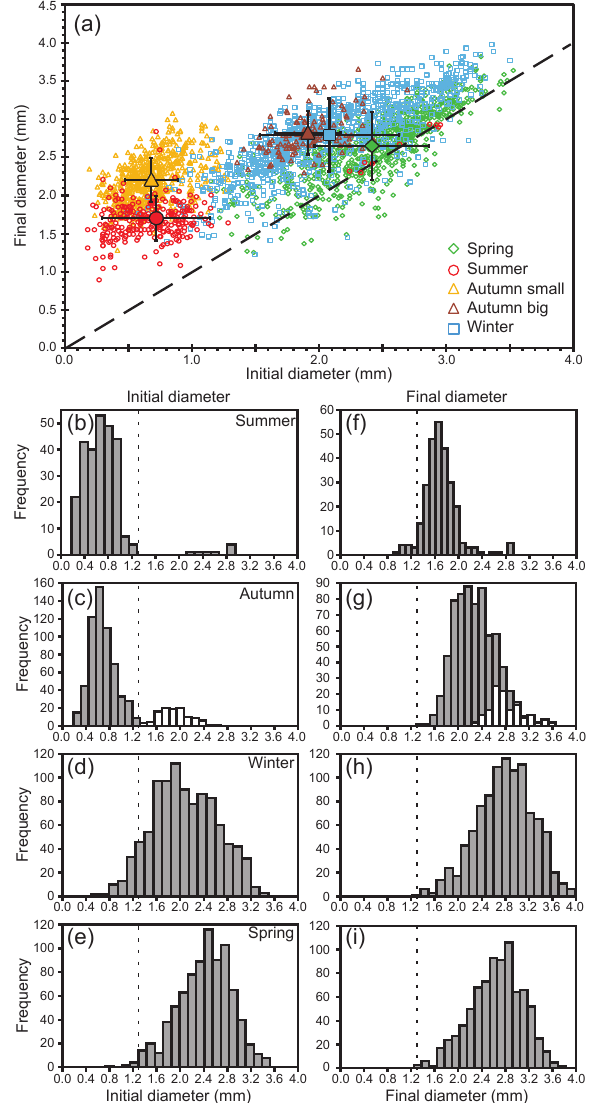
Figure 5. (a) Cross-plot of initial and final diameters of individual S. spirorbis tubes from all treatments and seasons. Note that only specimens that grew during the initial staining were included. Big symbols are seasonal mean diameters ( ± SD). The population of the autumn experiment was subdivided into a small and a big sub- population as described in the text. The tubes that plot above the dashed diagonal line of non-growth grew during the experiments. Note that most specimens of the spring and winter experiments plot close to this line indicating little growth. Specimens below the line showed deformations and irregular growth. (b–e, f–i) Size distribu- tions of S. spirorbis at the start and end of the four seasonal experi- ments respectively. Vertical dashed lines at 1.3mm indicate thresh- old diameter between small and large populations. White bars in (c, g) represent the autumn-big population. Frequency indicates num- ber of specimens in each size